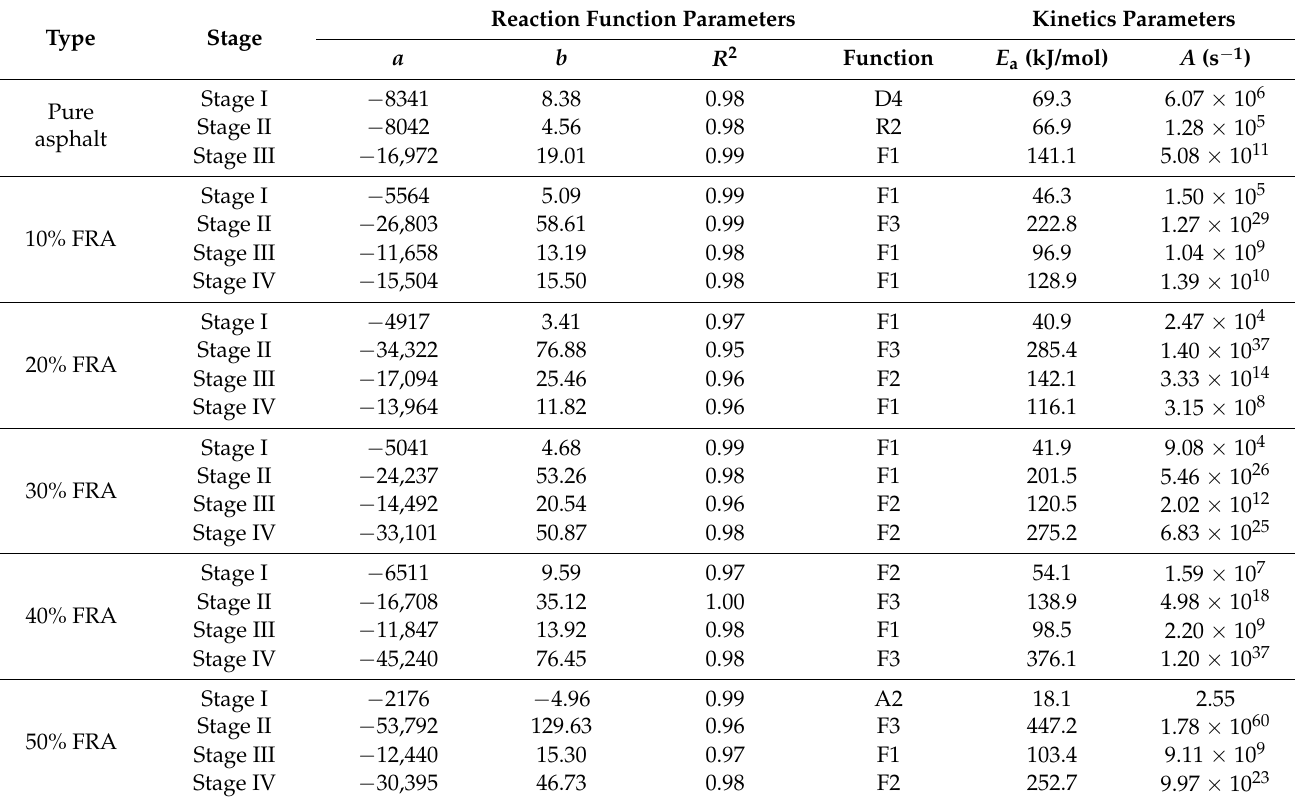
Table 5. Combustion reaction functions and kinetic parameters of